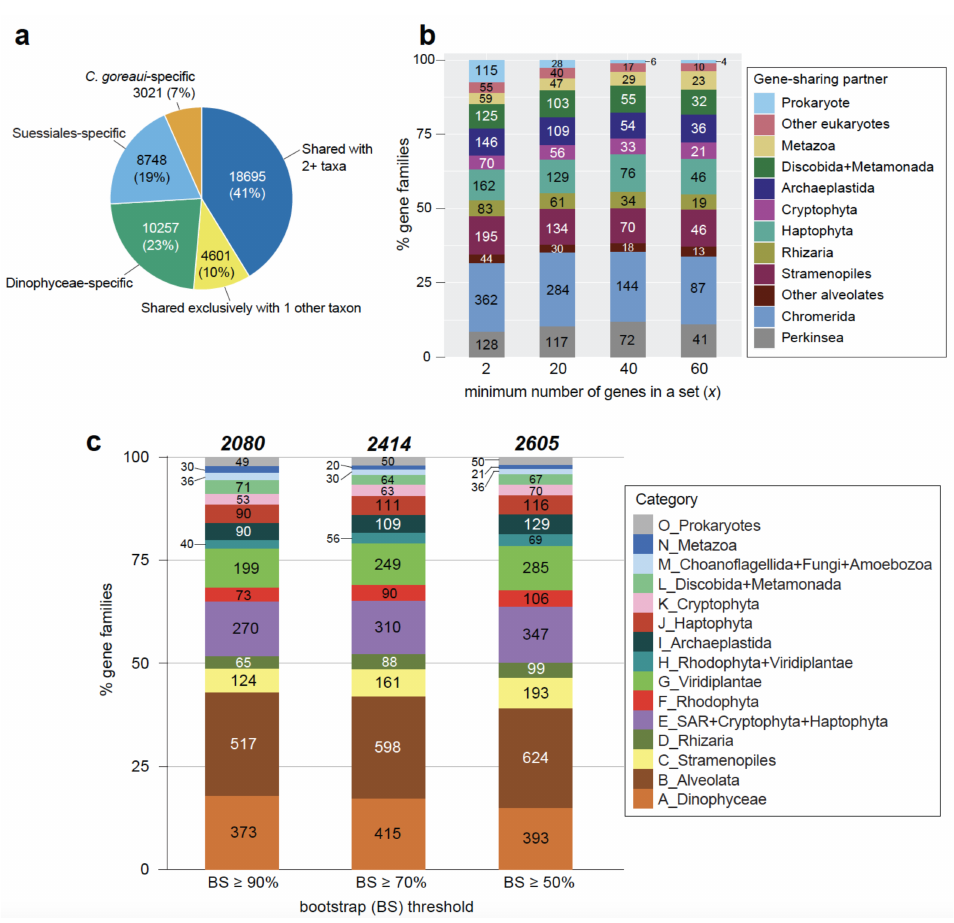
Figure 2. Evolutionary origins of C. goreaui genes. ( a ) C. goreaui genes classified based on the number of recovered protein homologs in other taxa. ( b ) Distribution of phyla with respect to exclusive gene-sharing partners for C. goreaui , based on the number of homologous sets that contain only C. goreaui and the other phylum, across the minimum number of genes in each set ( x ) at x ≥ 2, ≥ 20, ≥ 40, and ≥ 60. ( c ) Distribution of phyla that are found to share genes with dinoflagellates, based on the number of inferred protein trees in which dinoflagellates and one other phylum were recovered in a monophyletic clade, assessed at bootstrap support (BS) ≥ 90%, ≥ 70%, and ≥ 50%. All taxonomic classification follows NCBI Taxonomy, including Dinophyceae (Fritsch